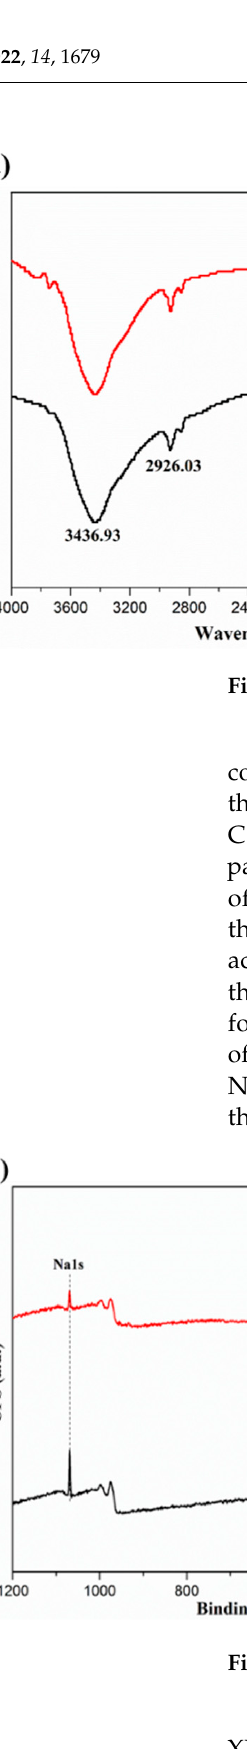
Figure 5. ( a ) XPS spectra and ( b ) XPS C1s narrow scans of SA and OSA. The crystal structure of OSA was evaluated by XRD. As shown in Figure 6, the XRD patterns of SA and OSA were proved to be amorphous structures, consistent with previous reports [45]. The typical characteristic diffraction peaks of SA at 2 θ = 14.5 ◦ and 22.0 ◦ represented the hydrated crystalline structure generated from the intramolecular hydrogen bonds of SA [46]. Compared with SA, the diffraction peaks of OSA were shifted